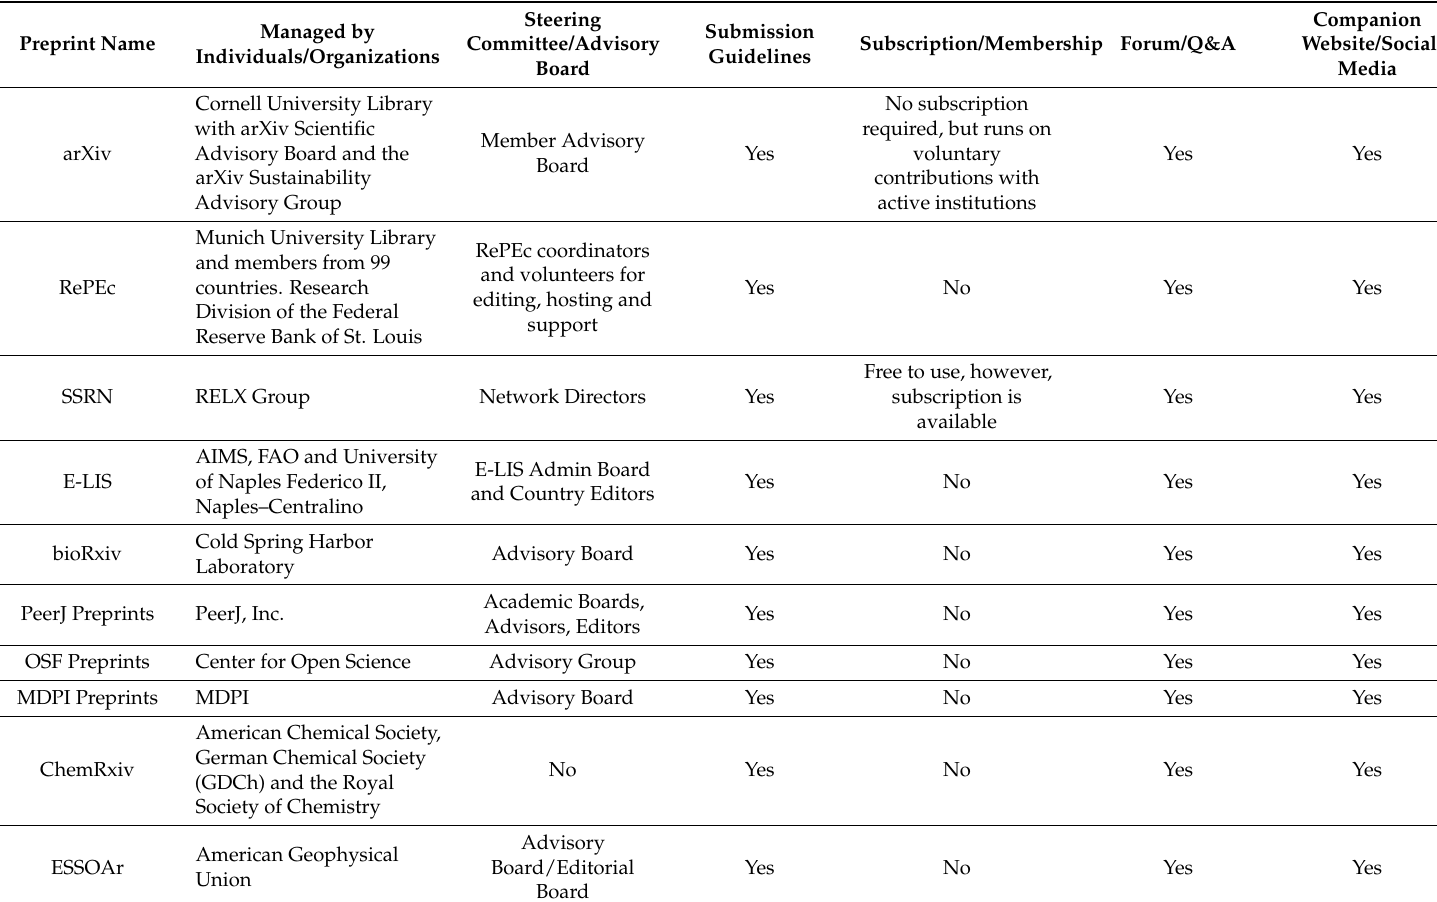
Table 3. Management of preprint